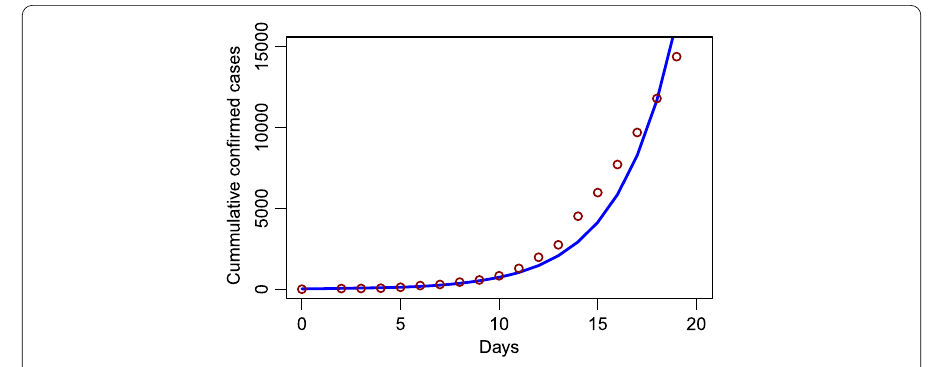
Figure 1 Cumulative confirmed cases for mainland China from January 15, 2020 to February 02, 2020 (see [22] for the data). Red circles denote the reported cases and solid blue line denotes the simulation result. The